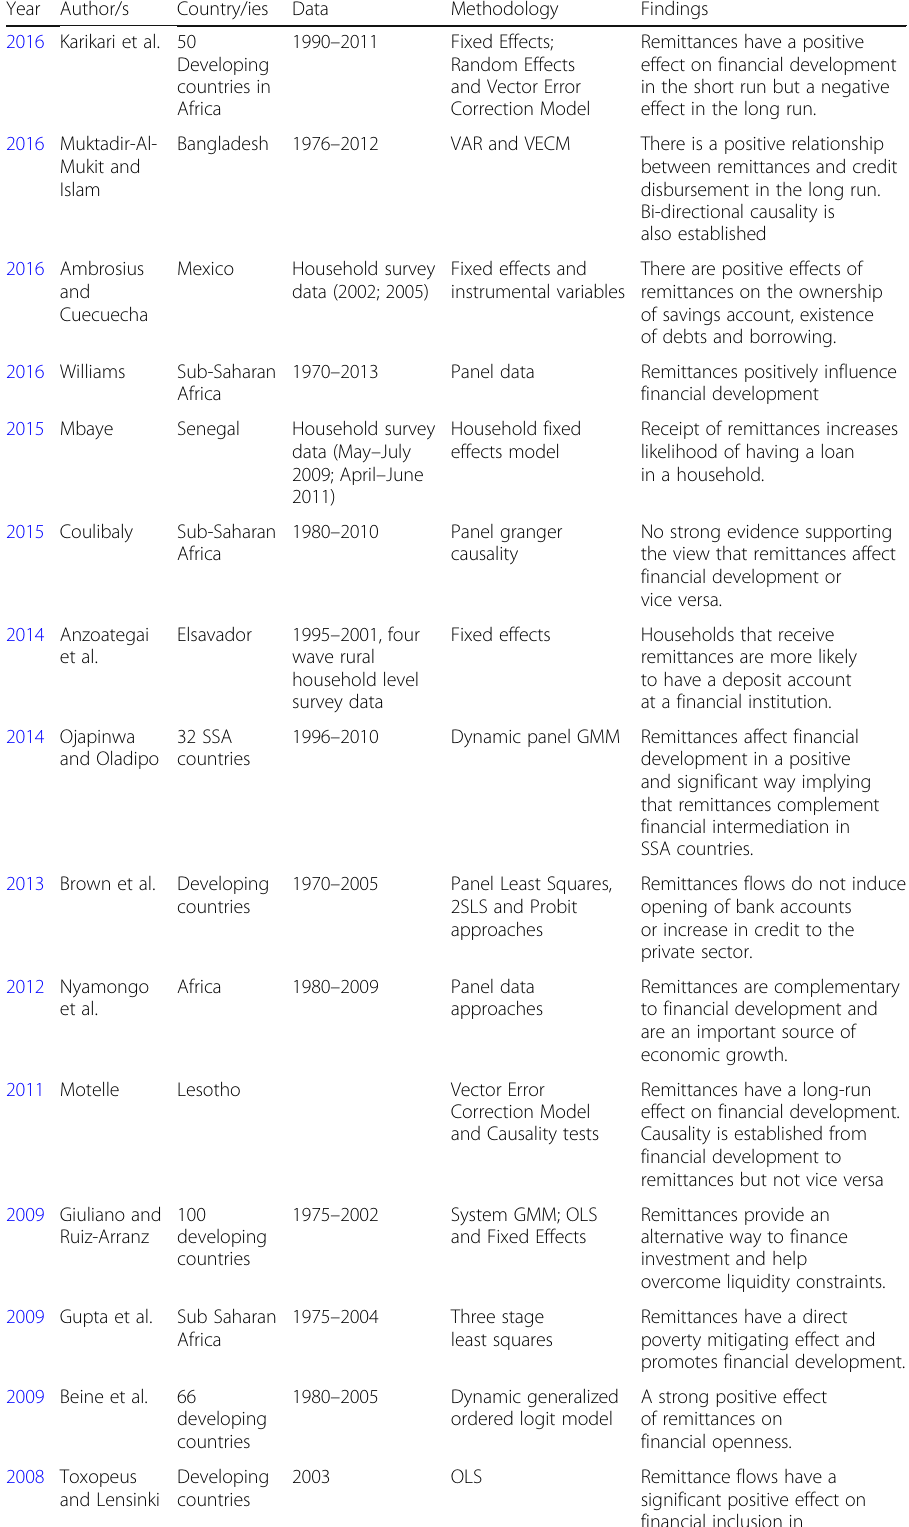
Table 1 Summary of International Empirical Evidence on remittances-financial